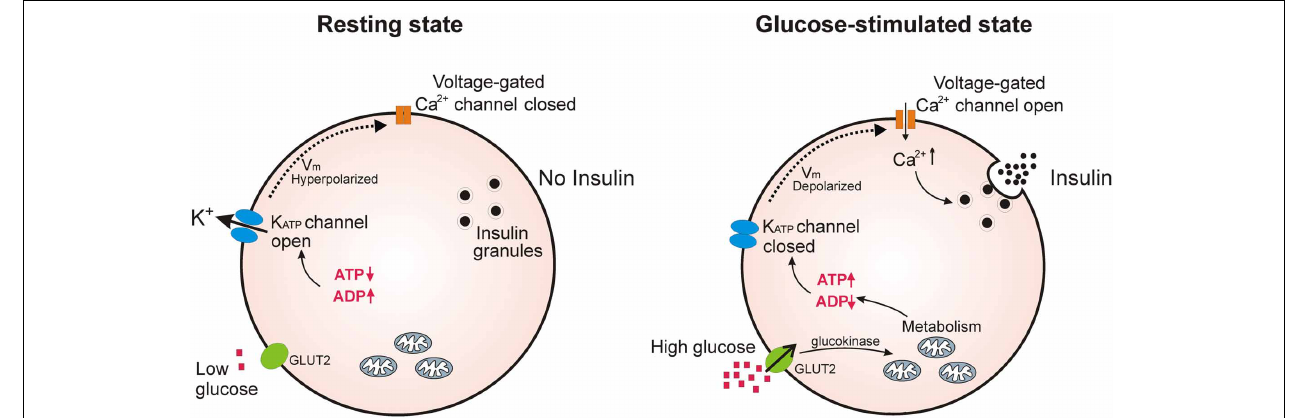
FIGURE 1 | K ATP channels regulate insulin secretion in pancreatic β -cells. Under conditions of low blood glucose, the relatively low ATP/ADP ratio in the β -cell promotes opening of K ATP channels, keeping β -cell membrane potential at a hyperpolarized state to prevent Ca 2 + influx and insulin release. Upon an increase in blood glucose, β -cells increase glucose uptake through